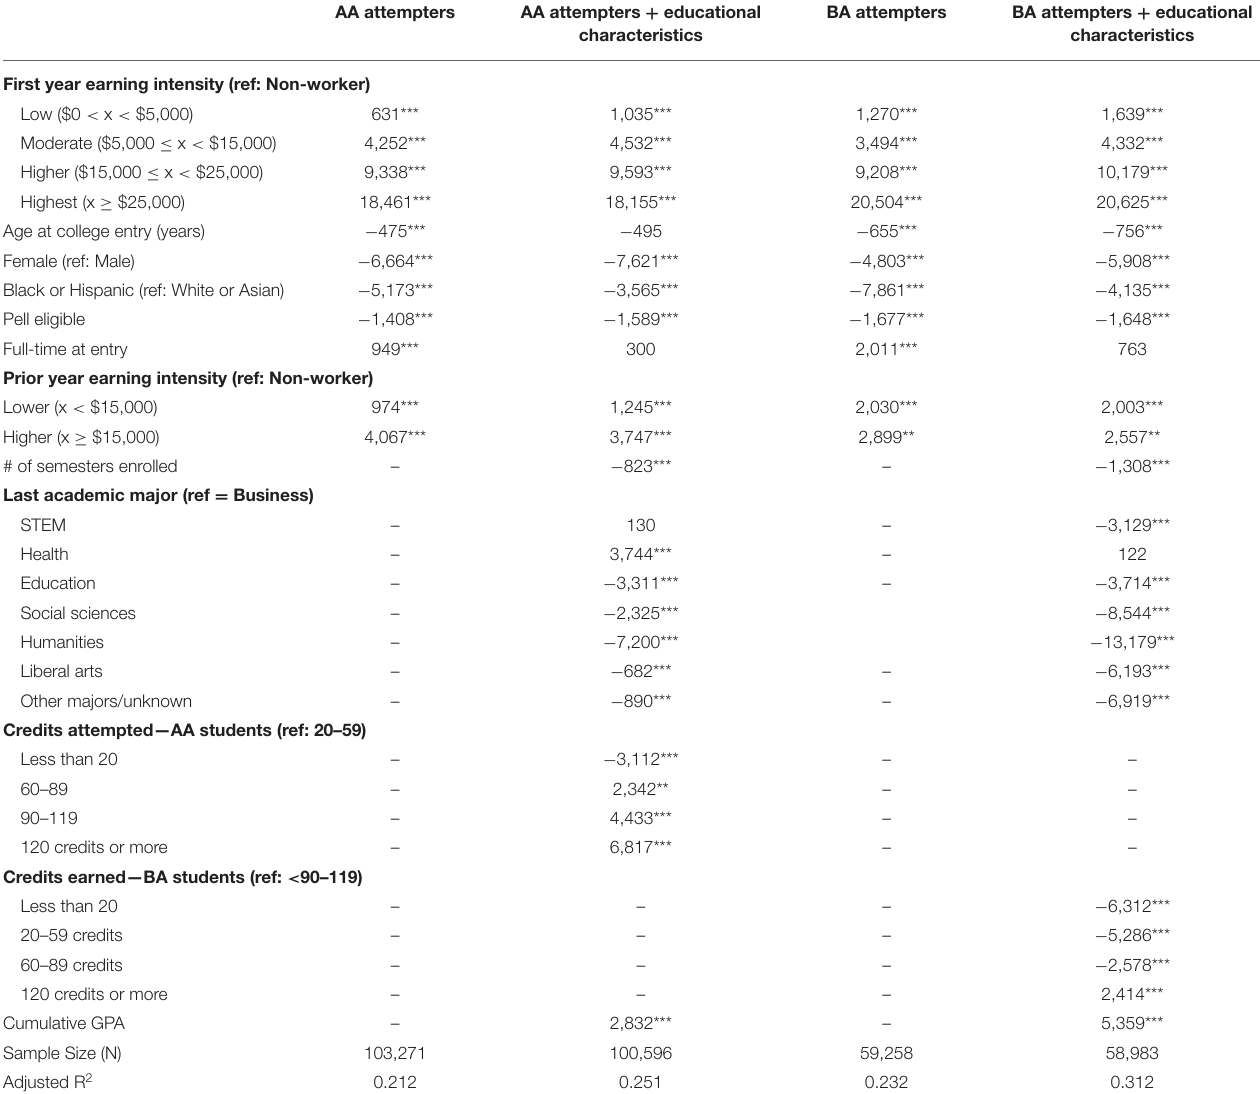
TABLE 4 | Effects of first-year earnings on post-college earnings in dollars ($). Ordinary least squares